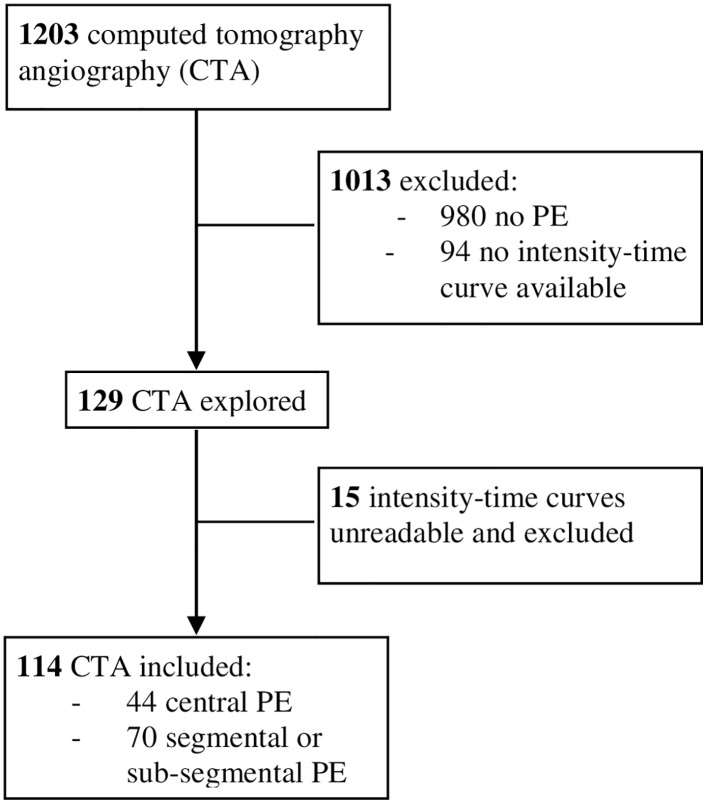
Flowchart of identified and included computed tomography angiographies (CTA).